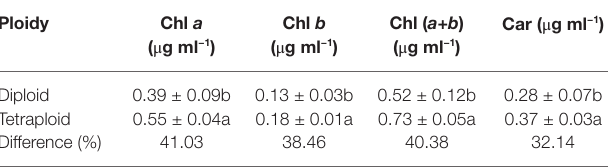
TABLE 1 | Photosynthetic pigment contents in the diploid and tetraploid barley leaves.